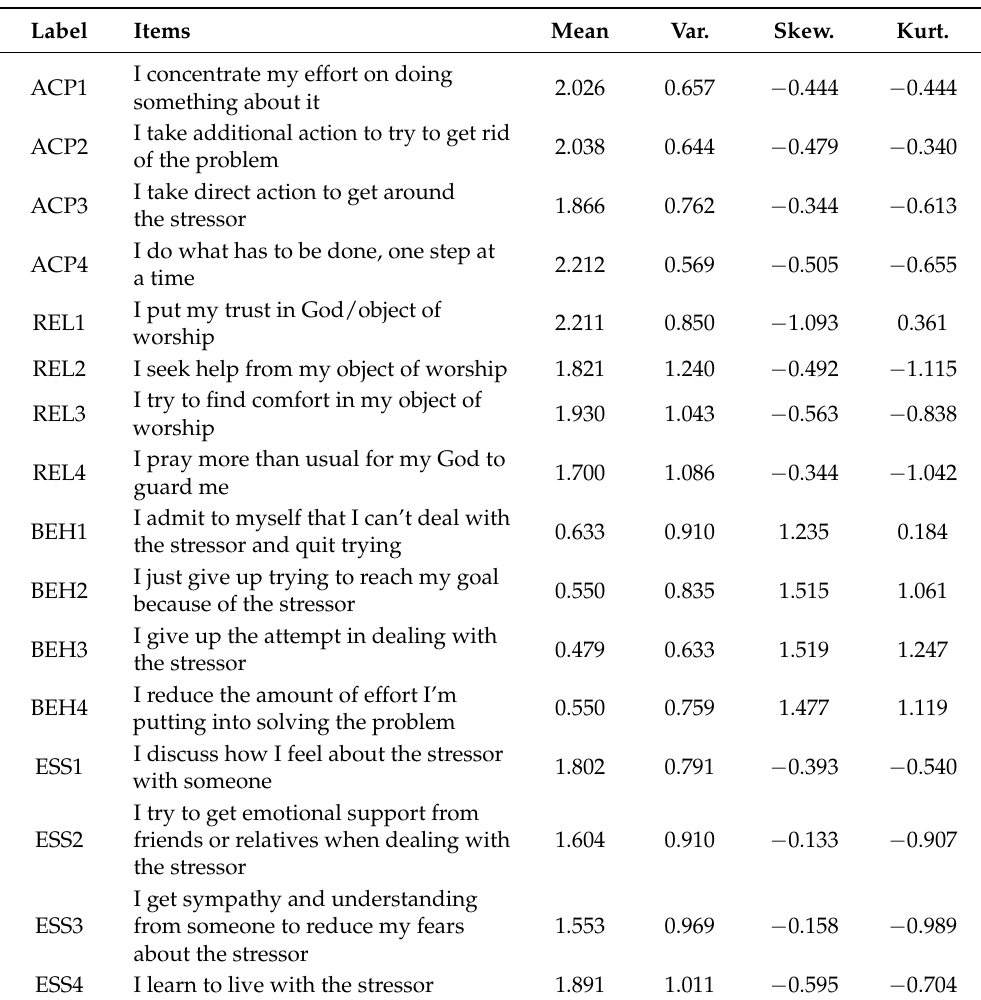
Table 2. The mean, variance, skewness and kurtosis of the items.